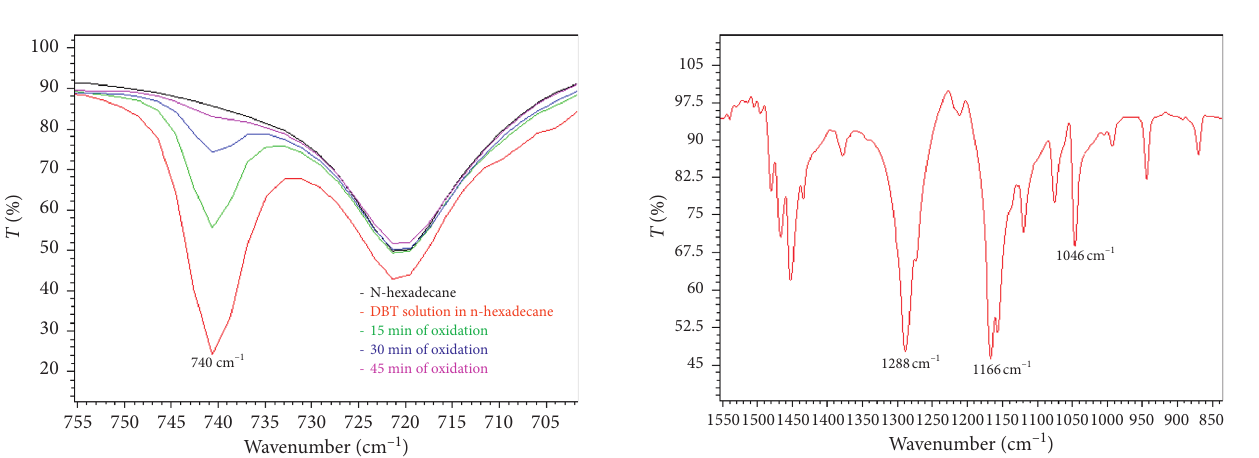
Figure 1: The intensity change of the characteristic “oop” peak of dibenzothiophene during 15, 30, and 45 minutes of oxidation.